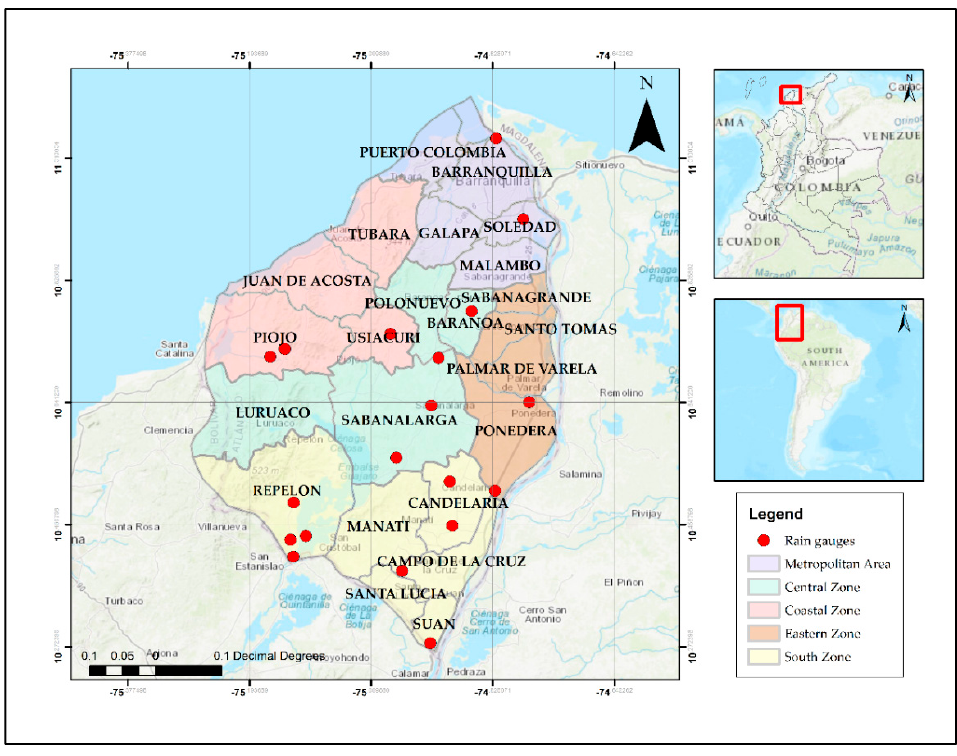
Figure 1. Political distribution of the department of Atlántico.